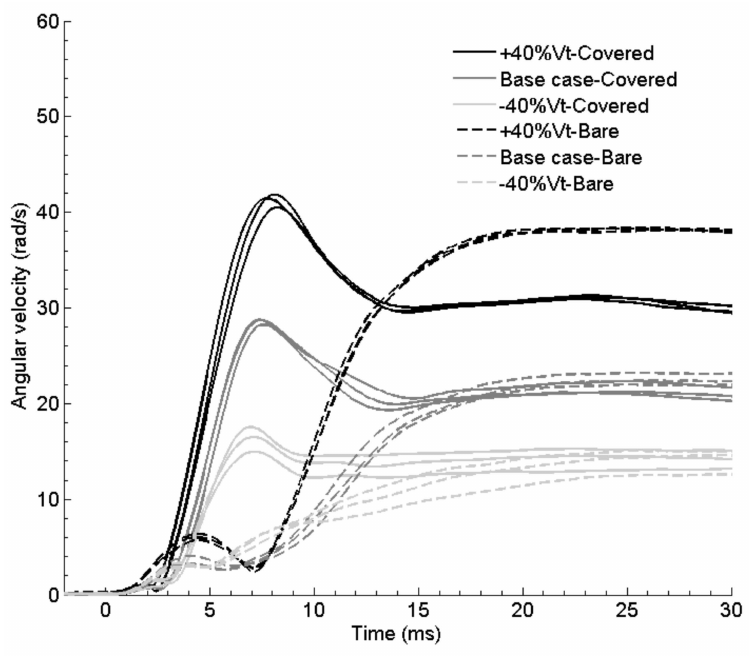
Figure 8. Resultant angular velocity for the left side impacts. Solid lines correspond to covered headform and dashed lines correspond to bare headform test.